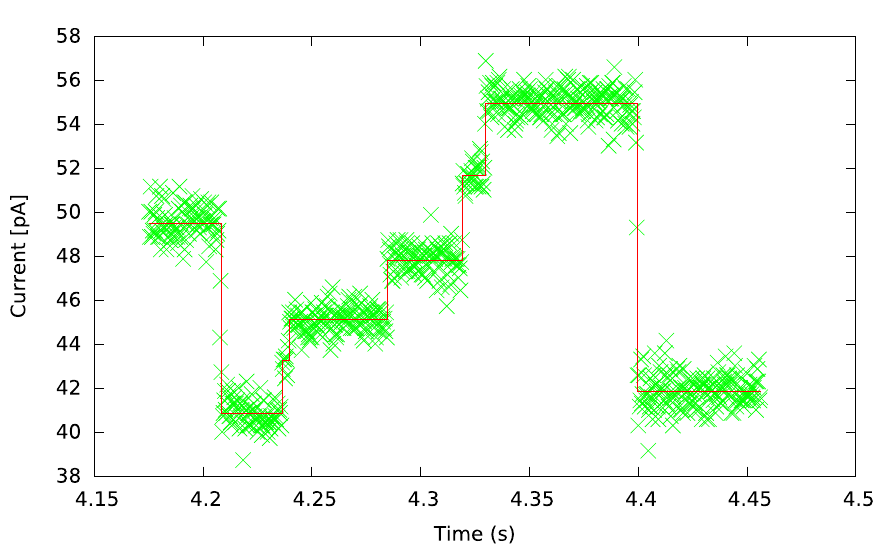
Fig 1. Raw signal from MinION and its segmentation to events. The plot was generatedfrom the E. coli data (http://www.ebi.ac.uk/ena/data/view/ERR1147230).